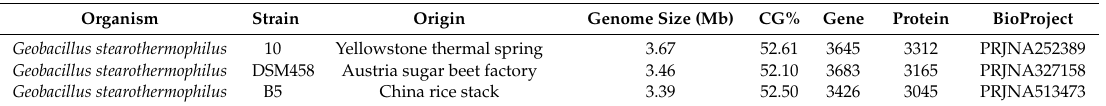
Table 2. List of G. stearothermophilus strains with sequenced genomes, as reported in the National Center for Biotechnology Information (NCBI) genome databank.